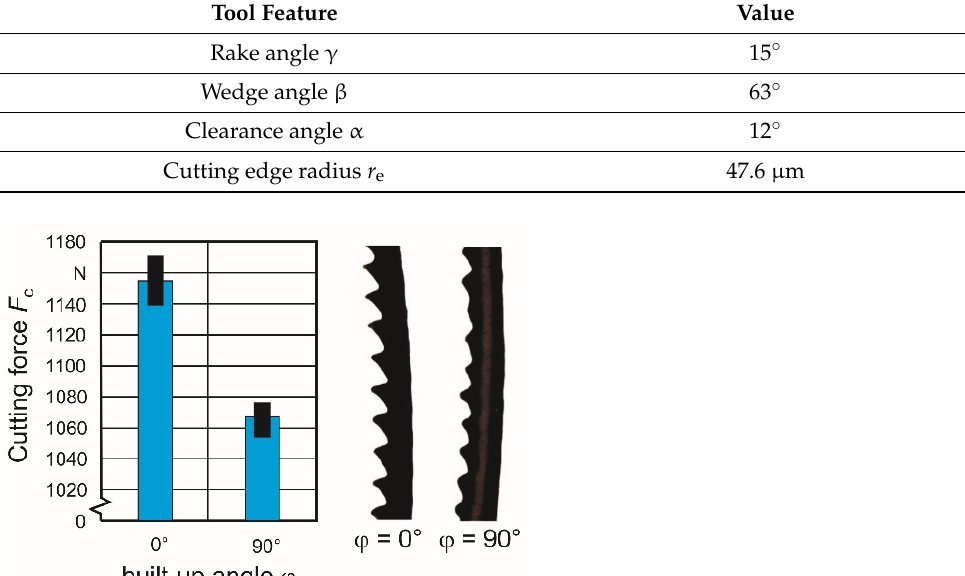
Table 3. Tool Specifications.